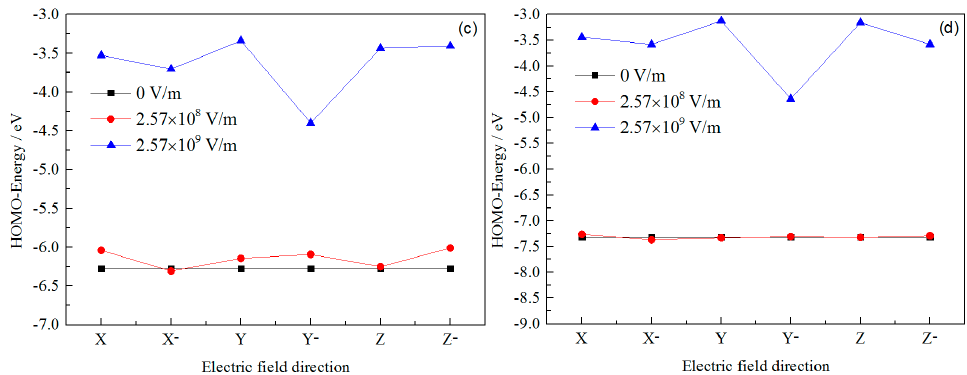
Figure 6. HOMO energy variations with applied fields: ( a ) 1-Methylnaphthalene; ( b ) eicosane; ( c ) triolein; and ( d ) tristearin.